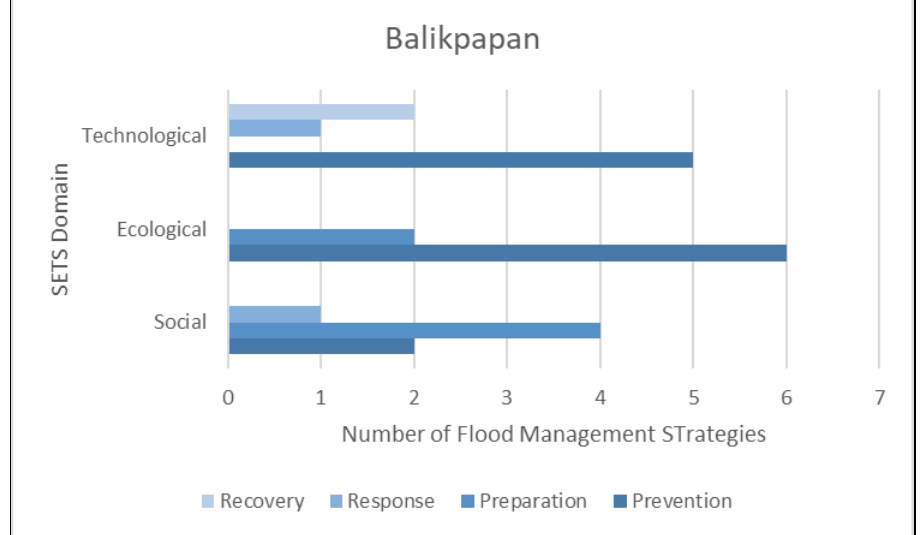
Figure 7. Flood Resilience Phase for the SETS domains in Balikpapan (Source: authors) .